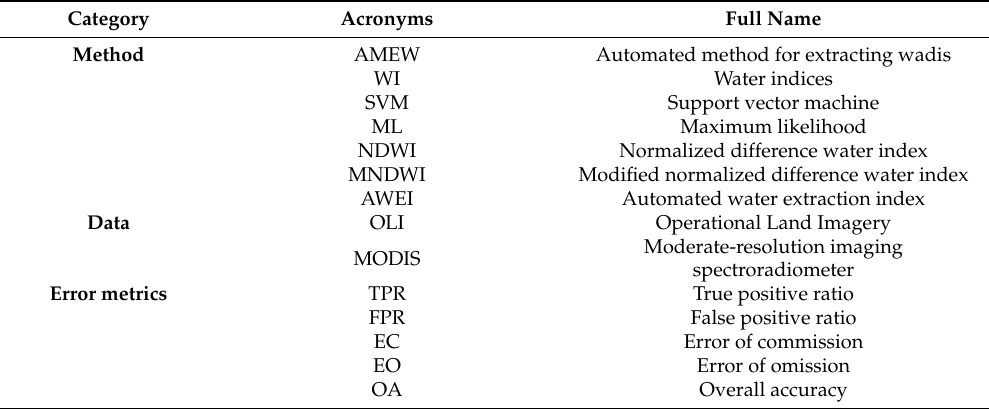
Table A1. Acronyms for common